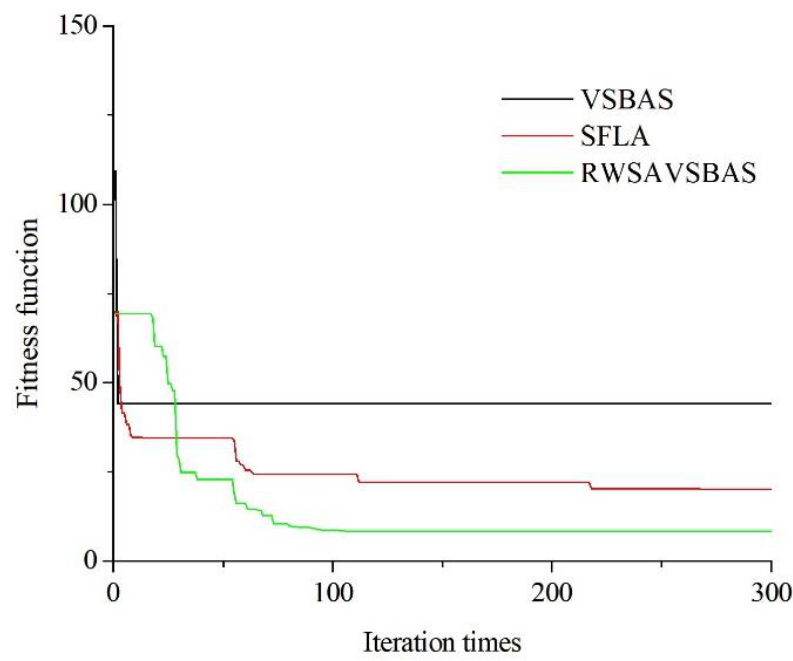
Figure 4. Evolution process figure.